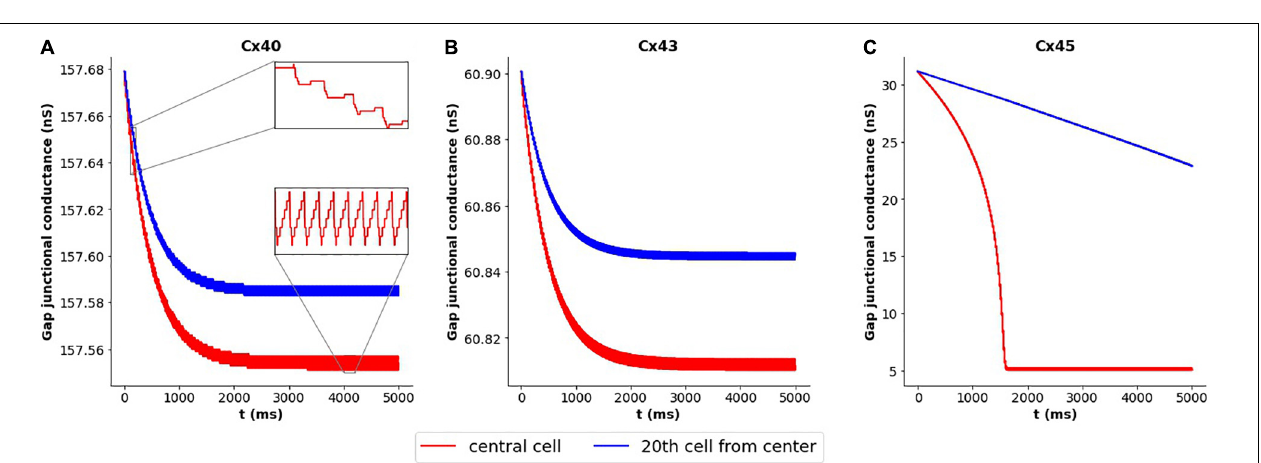
FIGURE 5 | Variations in the spiking frequency observed when simulating the 1-D model for a duration of 5000 ms with different gap junction subtypes. Panels show results for different gap junction subtypes: (A) Cx40, (B) Cx43, (C) Cx45. The traces in red correspond to membrane potential recorded at the central cell during the initial phase of the simulations (around 100–200 ms), while the traces in blue show the same during the final phase of the simulations (around 4,900–5,000 ms). The plots were aligned such as to match the peaks of the first APs in each subplot. It can clearly be seen that the simulations with Cx45 subtype exhibited a rise in the spiking frequency, whereas this remained constant in the case of Cx40 and Cx43.